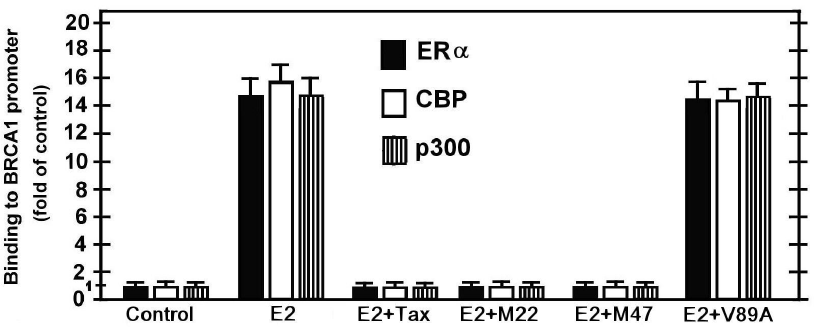
Figure 6. Effect of Tax on ER a -CBP/p300 complex binding to BRCA1 promoter. MCF-7 cells which were or not transfected with 1.5 m g of Tax variants [w.t.Tax, TaxM22, TaxM47 or Tax(V89A)] were treated with E2 at 5 hr before their extraction for examining the binding of ER a , CBP and p300 proteins to BRCA1 promoter by CHIP assay as described in Materials and Methods section. Control cells were not transfected with Tax and not treated with E2. The presented results are an average of three repeated experiments 6 SE.